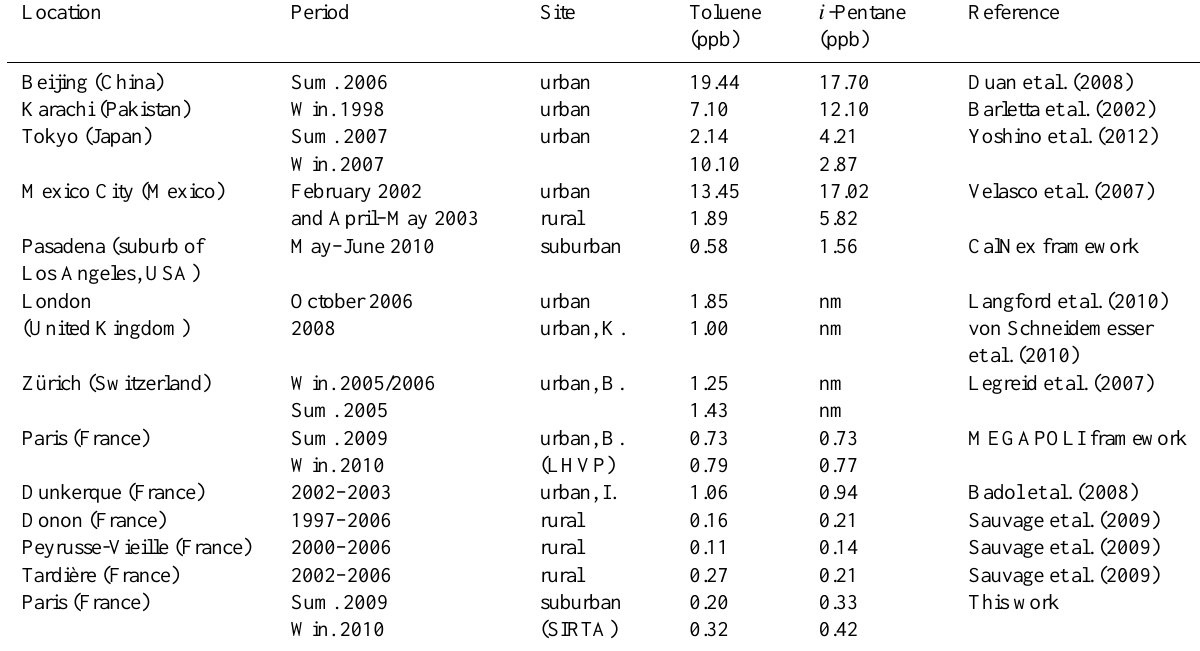
Table 4. Toluene and i -pentane mean concentrations in different cities worldwide.